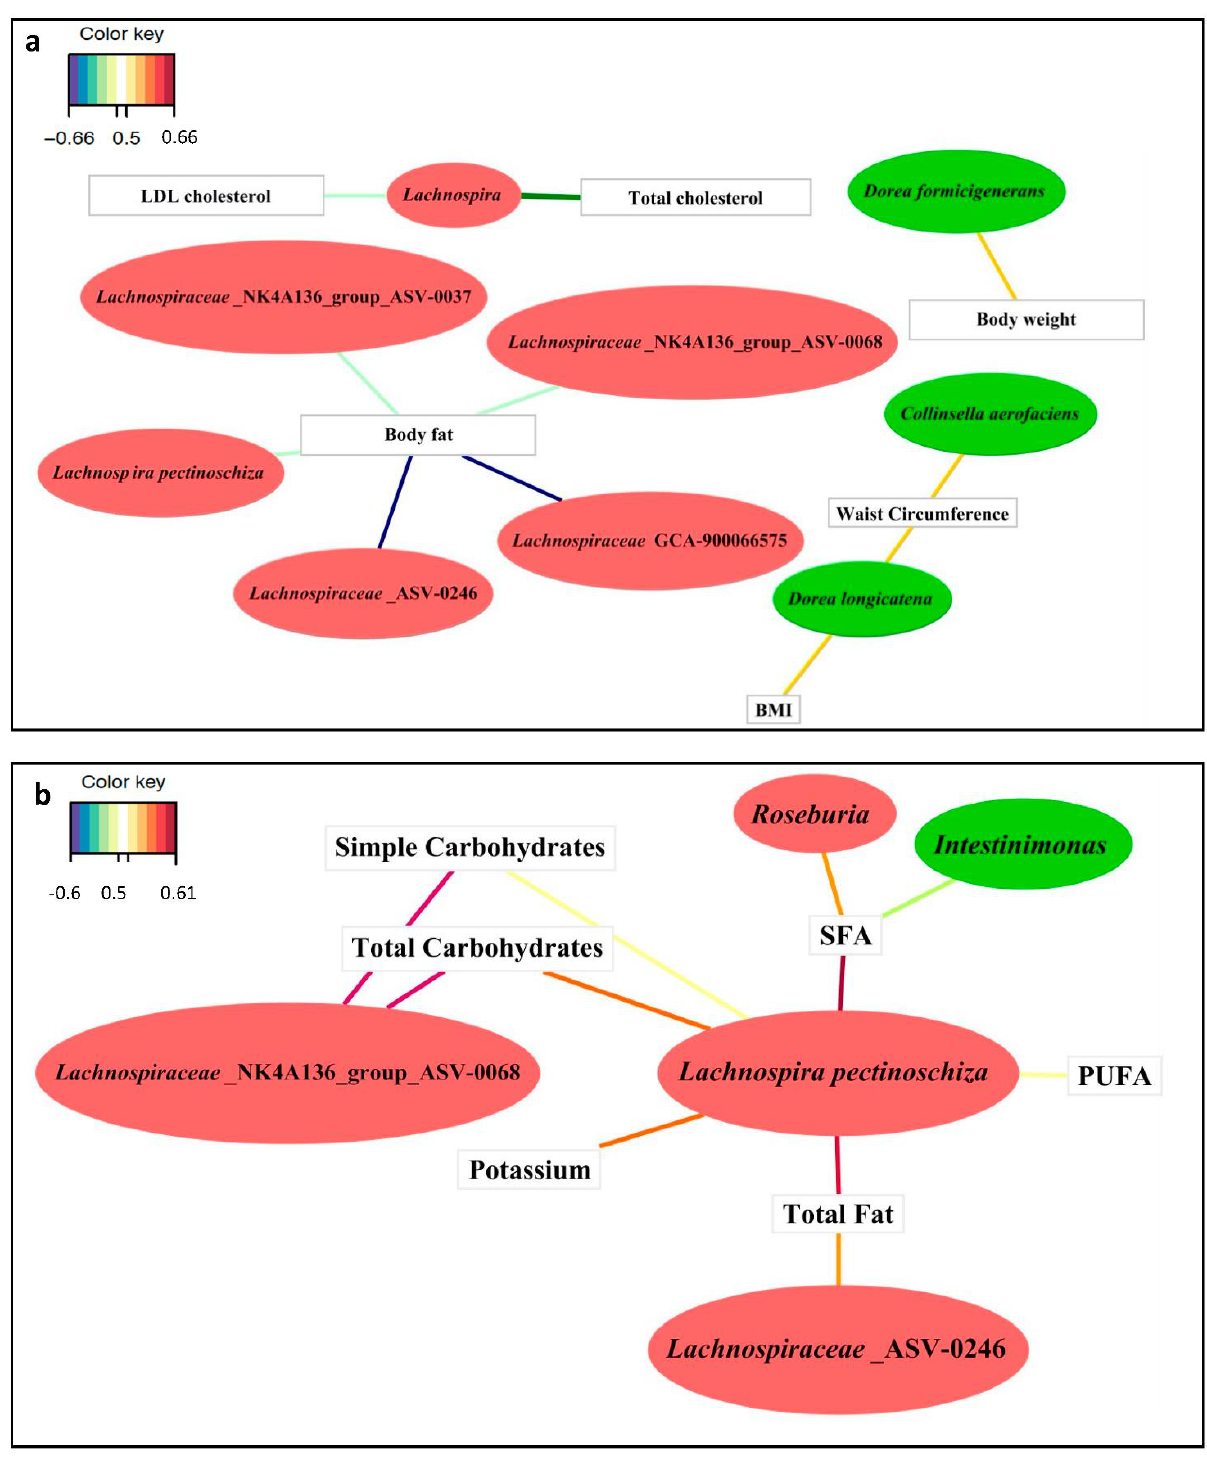
Figure 3. Relevant associations at the ASV level detected by sPLS. ( a ) Relevant correlations for anthropometric variables and the lipid profile with the ASVs showing the greatest difference between the overweight/obese and lean groups. ( b ) Relevant associations between dietary intake variables and the ASVs showing the greatest difference between the overweight/obese and lean groups. Green bubbles show ASVs biomarkers that were significantly increased in the overweight/obese group, and red bubbles show ASVs biomarkers that were significantly increased in the lean group; According to Color key code, the positive and negative associations were related with line colors: purple, red, orange and yellow colors indicated positive associations (from more to less correlation index); blue and green colors indicated negative associations (from more to less correlation index).